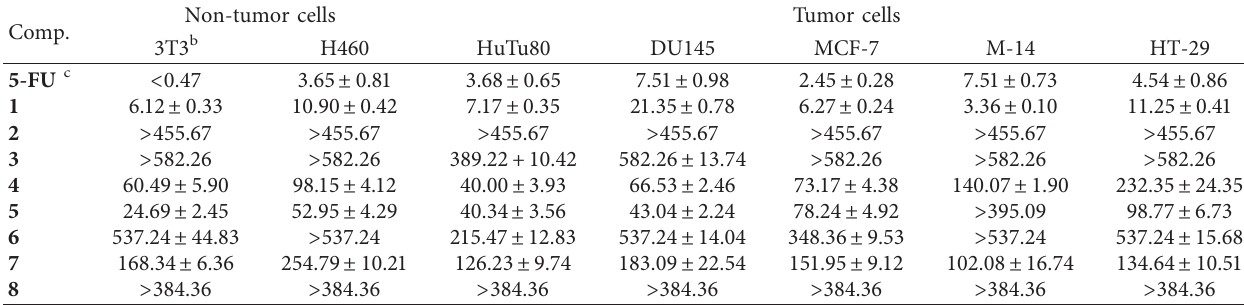
Table 3: IC a of the pyridine-3-carbaldehyde thiosemicarbazone derivatives ( 1 – 8 ) against the 3T3 non-tumor cells and the 50 ( μ M ) values different human tumor cell lines.